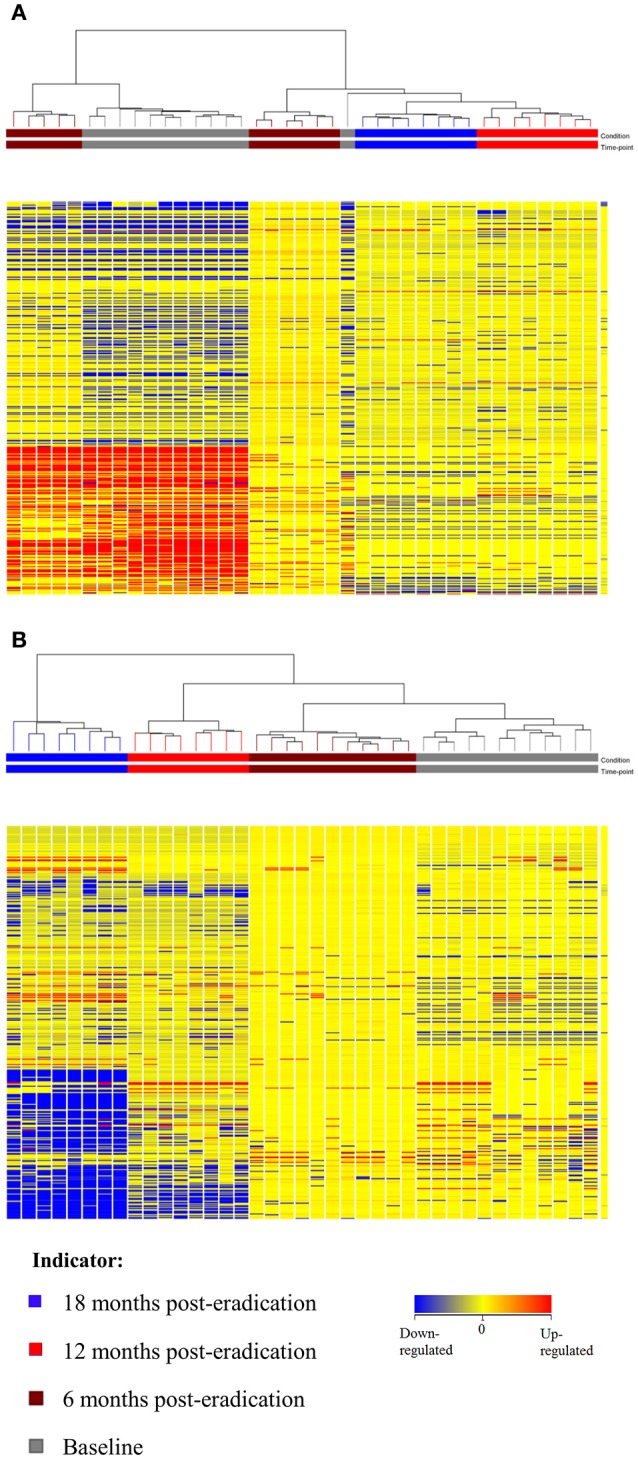
HCA dendrogram of fecal lipidomics for Baseline, 6, 12, and 18 months post-H. pylori eradication, acquired under both (A) positive and (B) negative ionization modes.